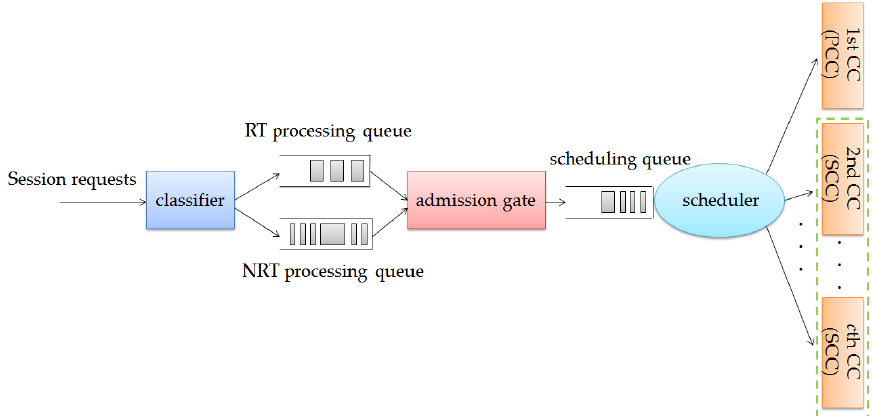
Figure 1. The system model for the present study. The dotted line surrounding the SCCs indicates that those SCCs can be turned off based on the traffic load.